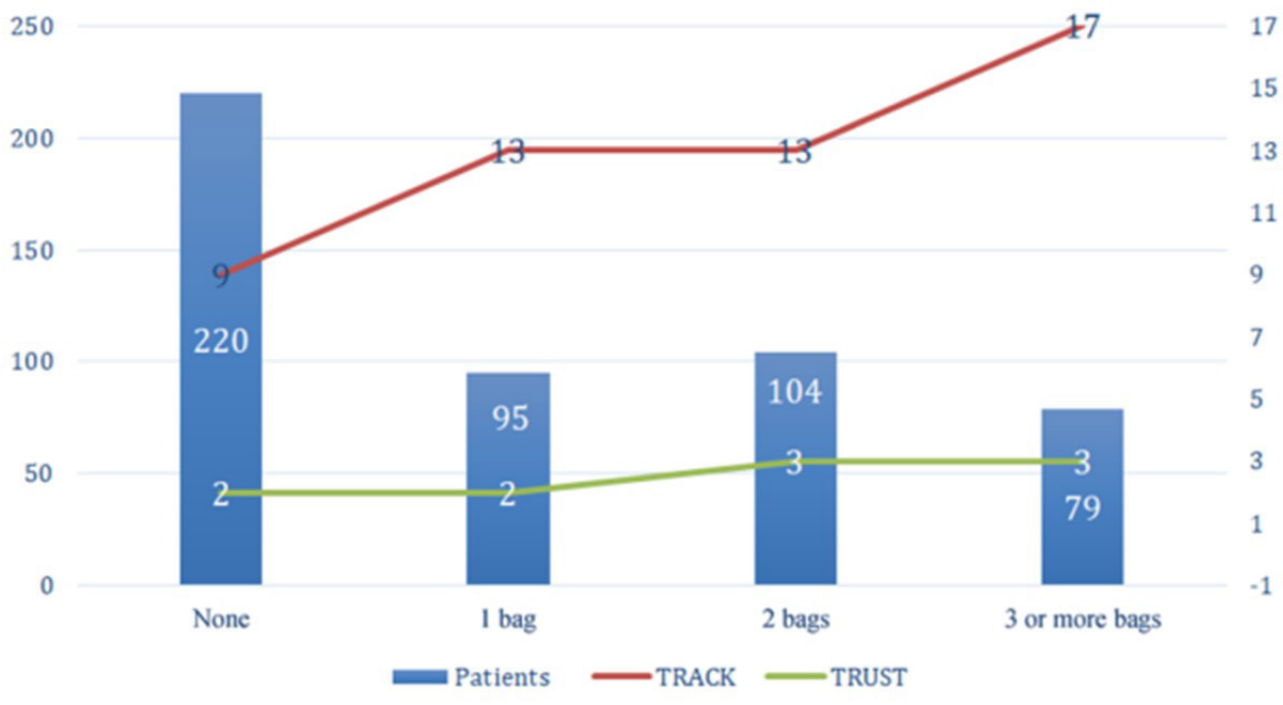
Fig. 2 - Transfusion Risk Understanding Scoring Tool (TRUST) and Transfusion Risk and Clinical Knowledge (TRACK) scores compared with number of blood bags. Kruskal-Wallis test, P-value < 0.001. Table 6. TRUST score categories vs. number of blood bags. Number of blood bags used Total None One Two Three or